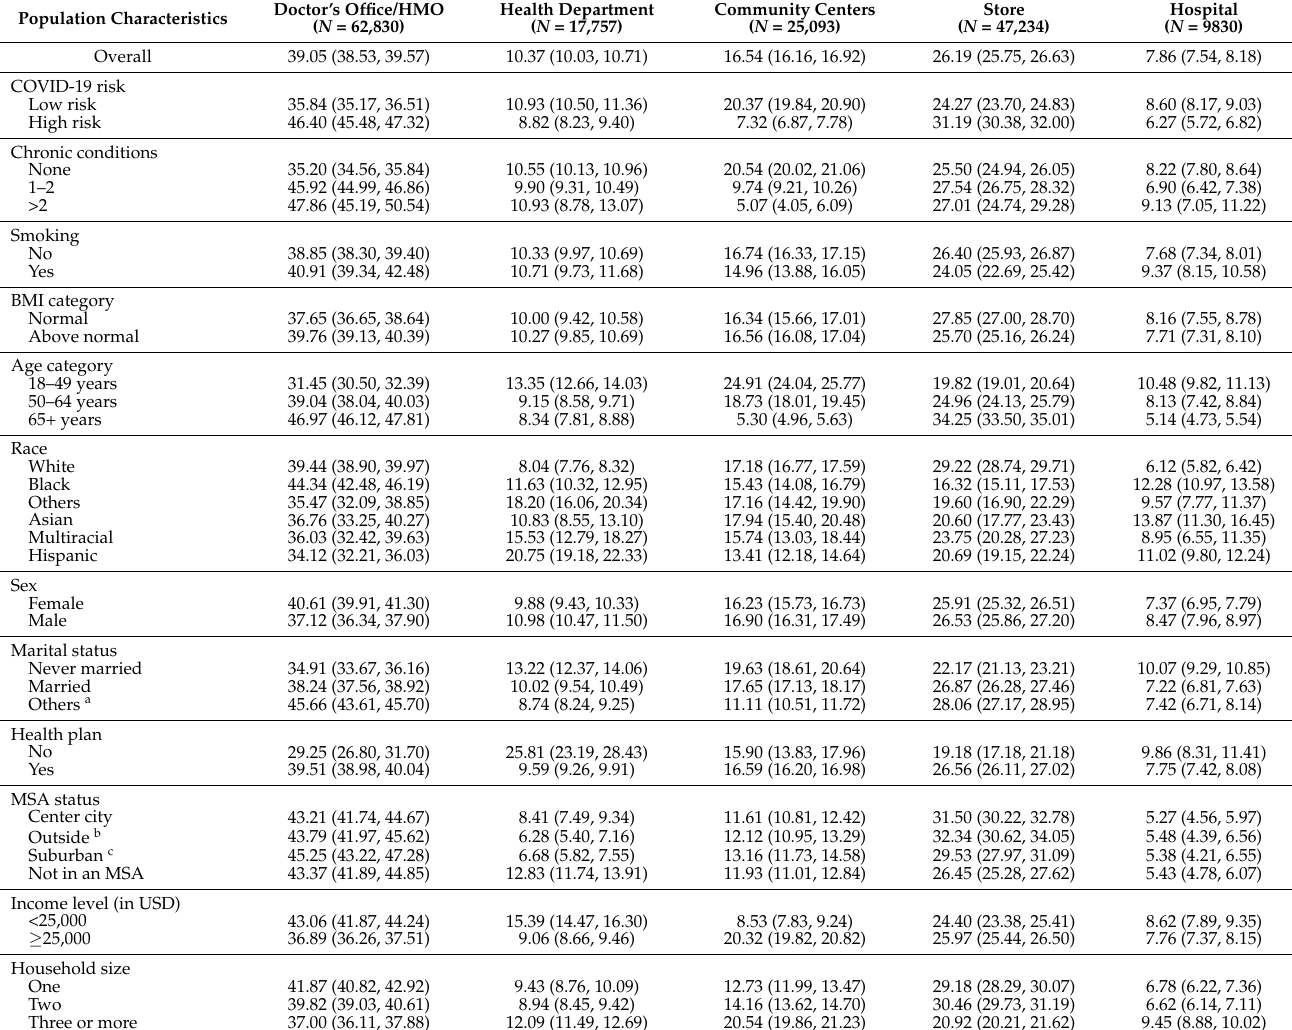
Table 1. Place of vaccination by COVID-19 risk groups and individual risk factors among US adult population, BRFSS 2018. Population